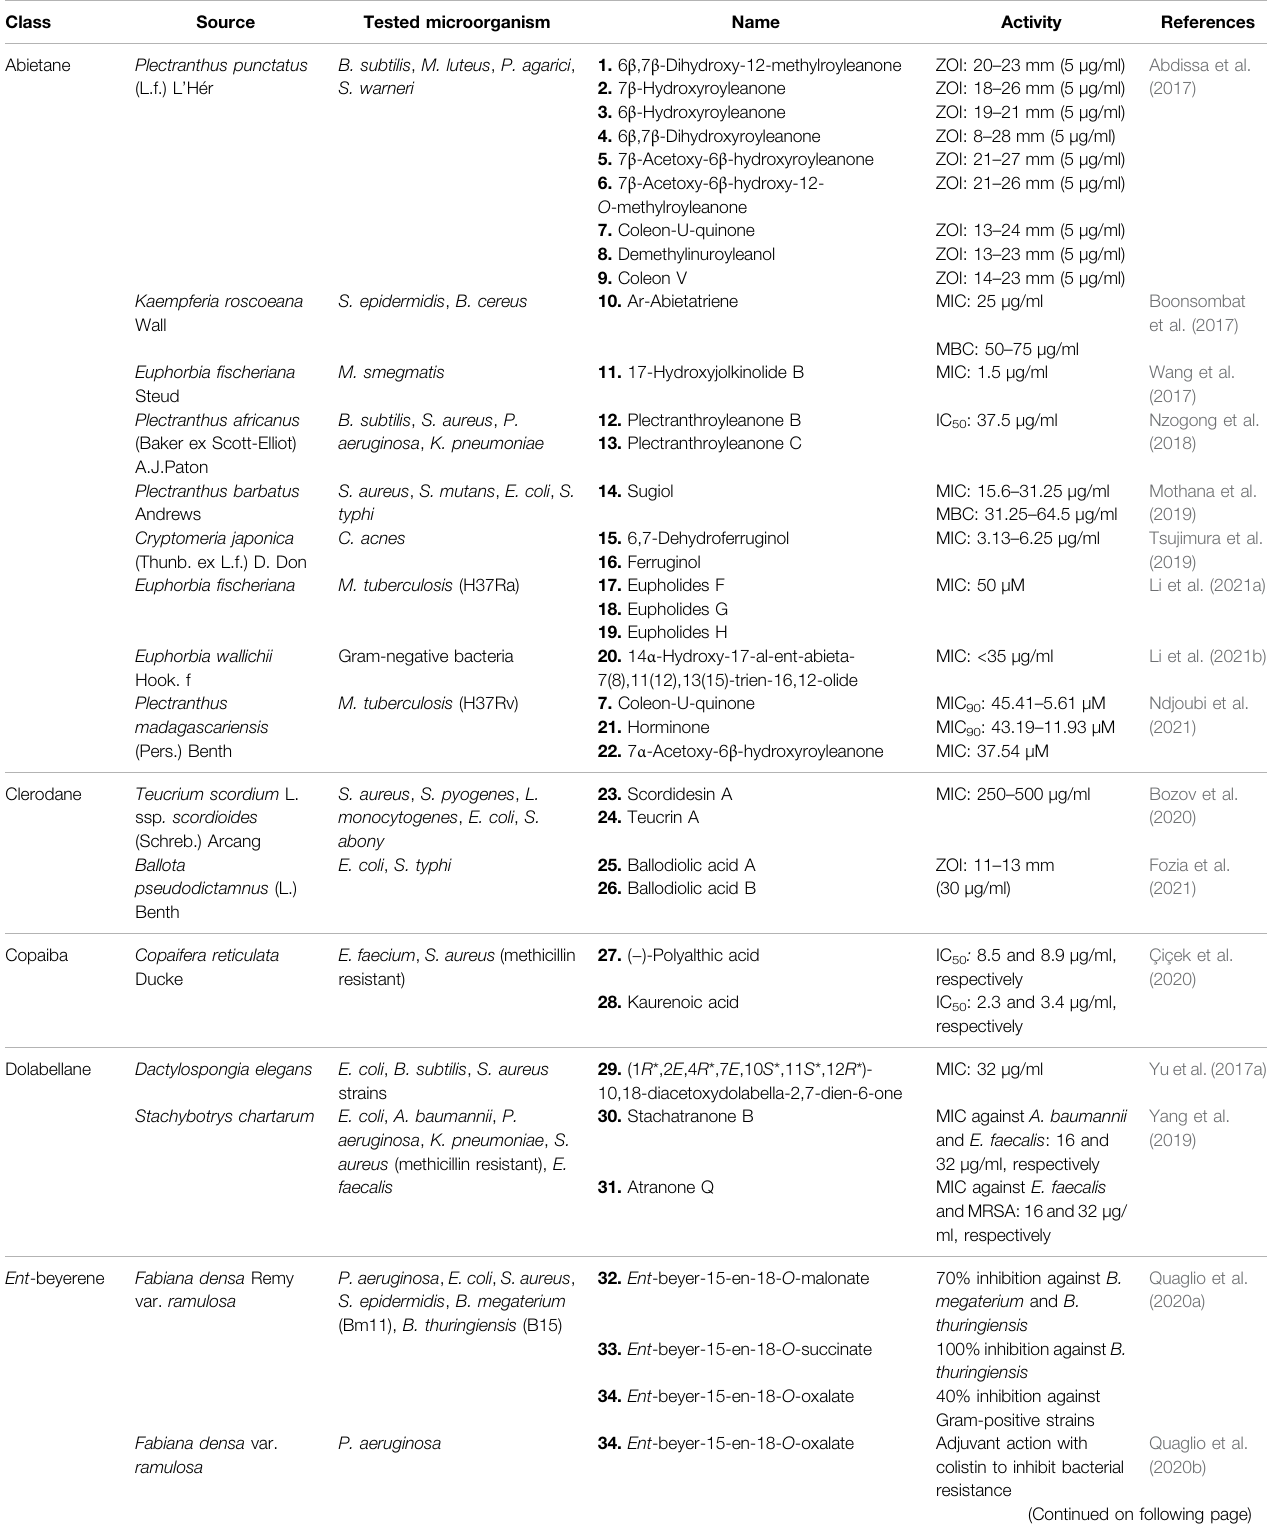
TABLE 1 | Different classes of diterpenoids isolated from natural sources with signi fi cant antibacterial activity.